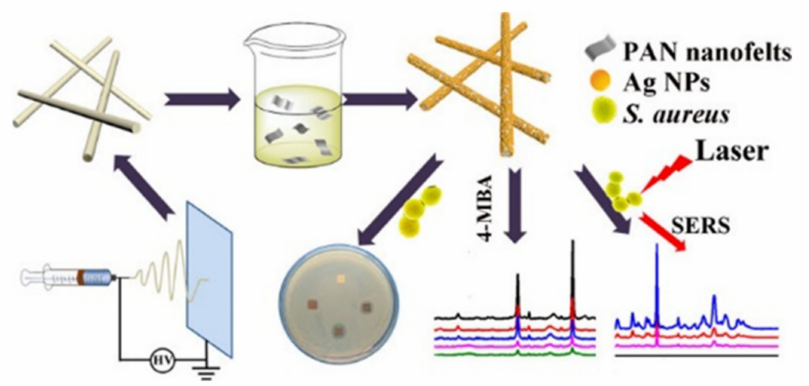
Figure 9. A simple electrostatic spinning technique to prepare Ag@PAN nanofiber membranes for bacterial detection [95]. Copyright 2020 American Chemical